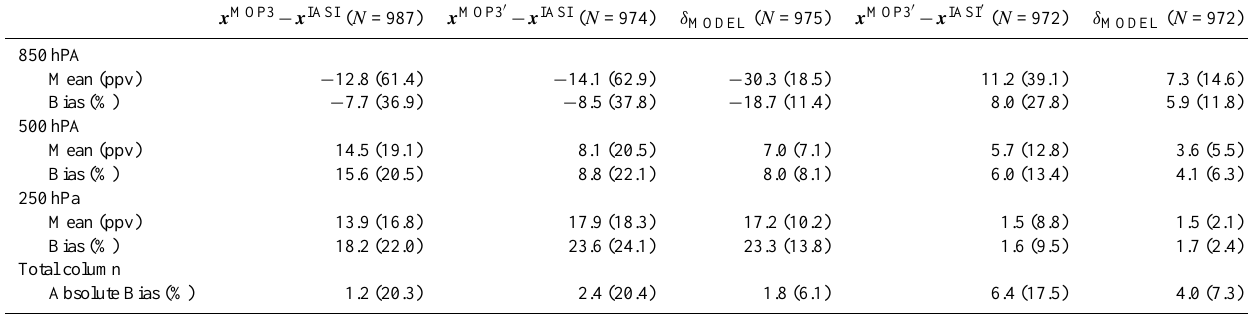
Table 1. Mean and percentage biases for IASI and MOPITT V3 CO profiles, as well as the mean absolute total column biases between the two products, for daytime over the oceanic Southern Africa region on 1 September 2007. N represents the number of retrievals, and the parentheses denote the standard deviations relative to the mean. Note also that the percentage biases represent the ratio to the mean IASI